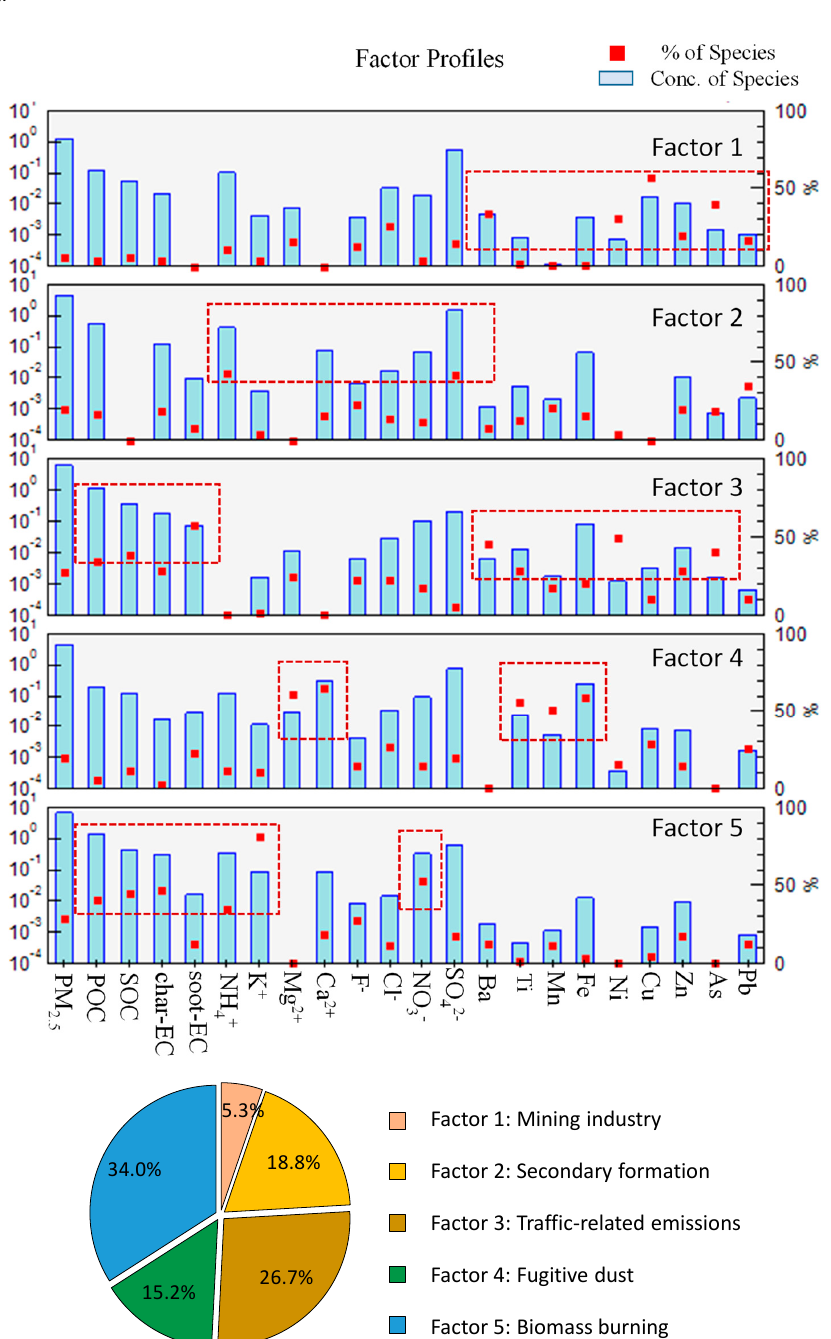
Figure 3. Source apportionment of PM 2.5 at the sampling